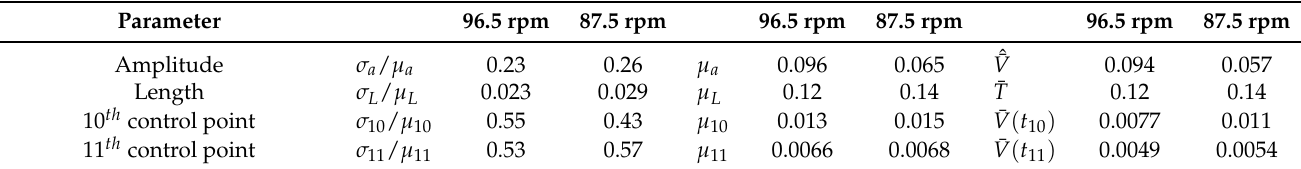
Figure 6. Schematic procedure of the data processing from the raw sound pressure signal to the input data of the Monte Carlo simulation. The filtering and integration process is described in detail in [13]. Table 3. Stochastic parameters evaluated from blade passage of group B and corresponding features of the respective mean volume signal ¯ V ( t )